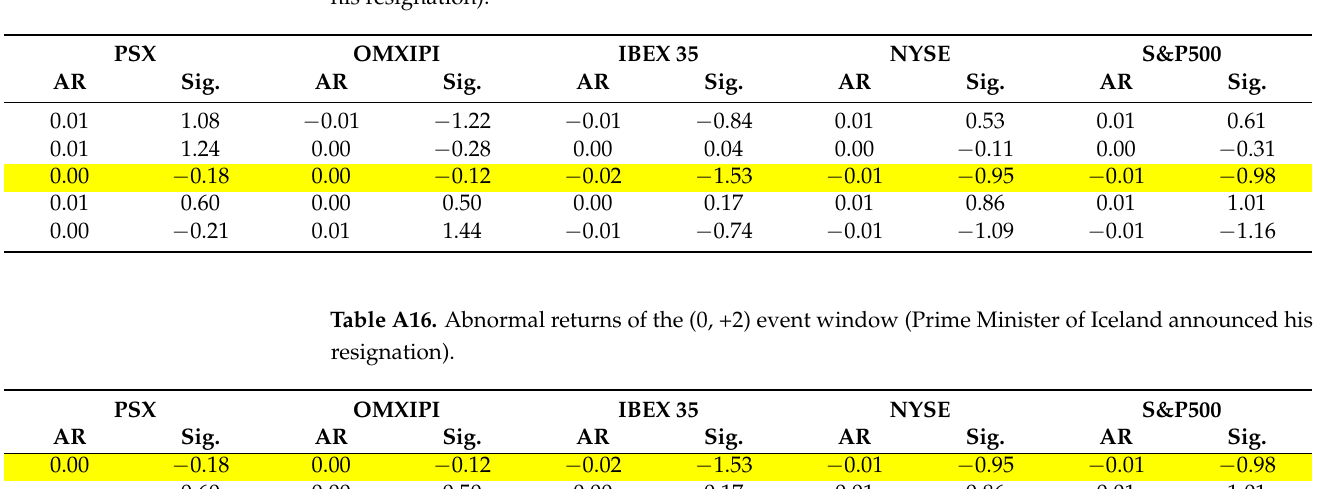
Table A15. Abnormal returns of the ( − 2, +2) event window (Prime Minister of Iceland announced his resignation).